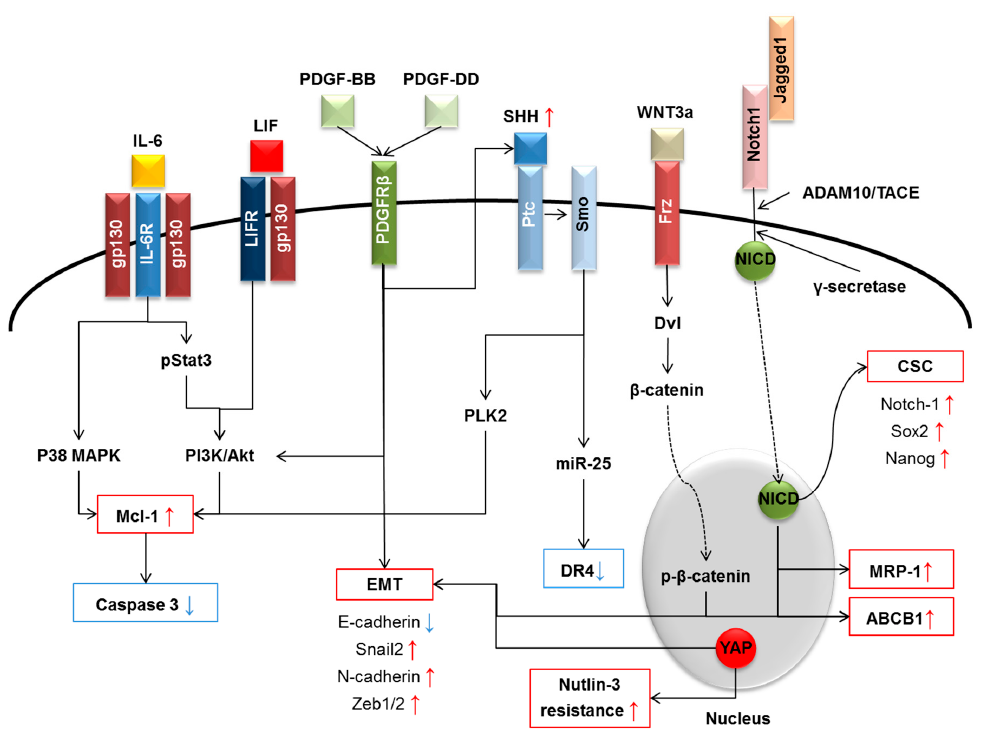
Figure 1. Molecular mechanisms of chemoresistance in CCA induced by autocrine and